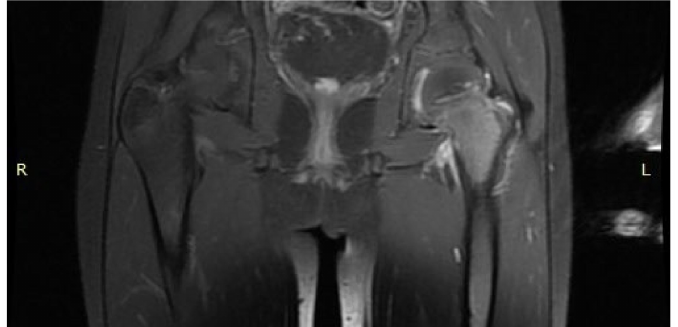
Figure 14. MRI scan of the hip joints showing oedema of the left femoral neck and suggesting inflammation of the hip joint, no nidus revealed.